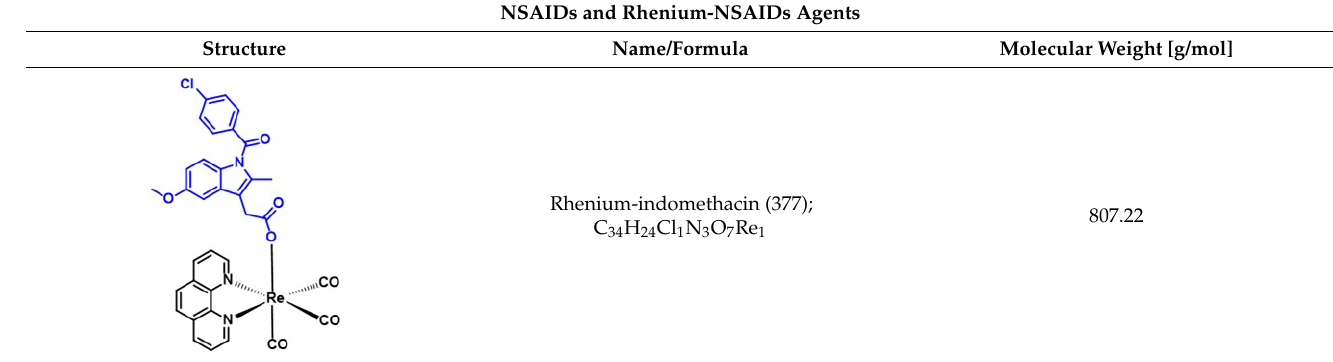
Table 5. Cont. NSAIDs and Rhenium-NSAIDs